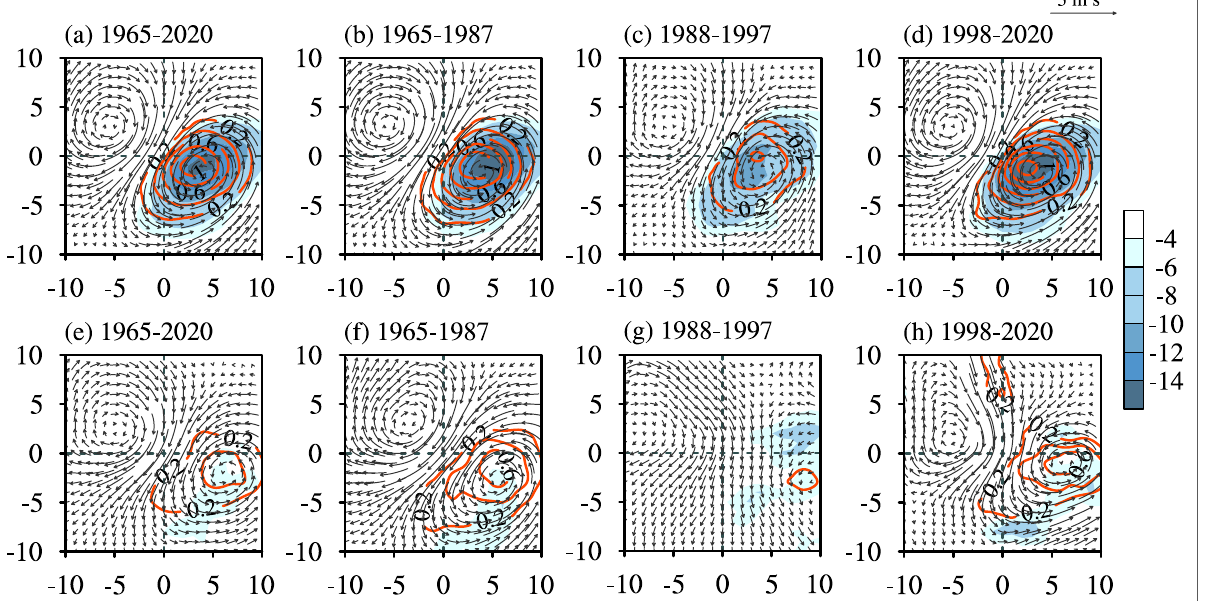
10 –5 s − 1 to 2 10 –5 s − 1 by 0.2 10 –5 s − × × ×